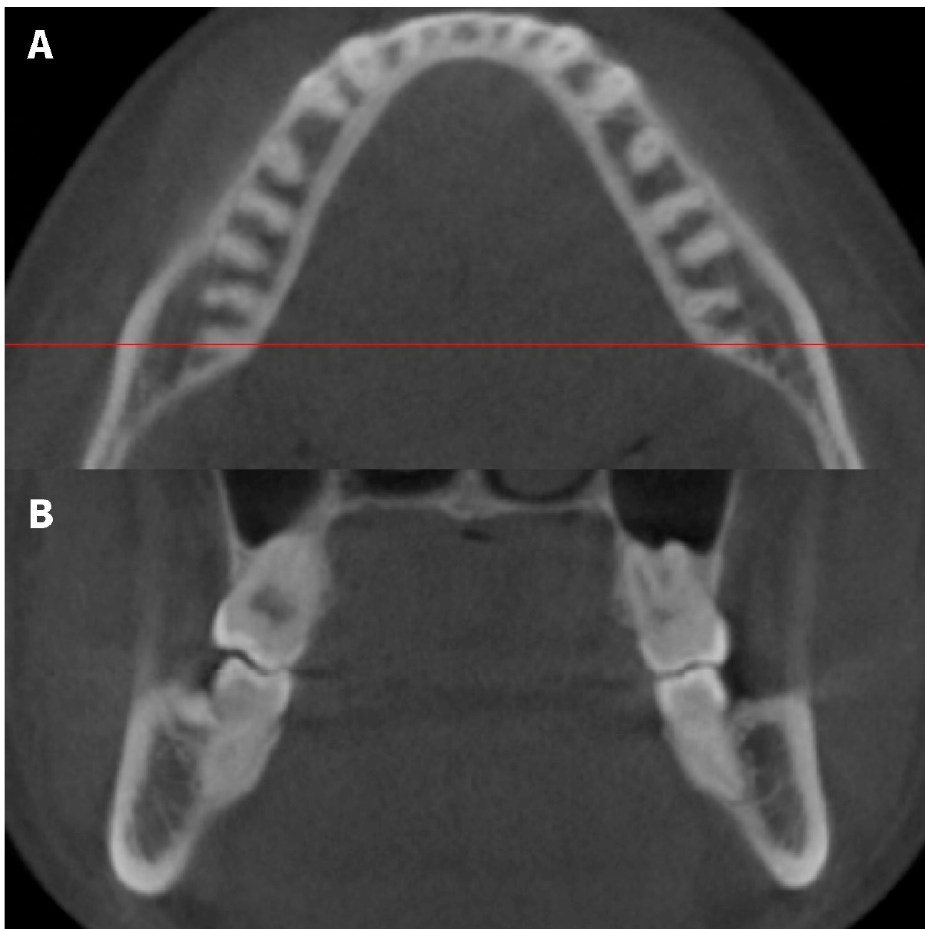
Figure 5. CBCT multiplanar reconstruction images showing contacts between distal roots of mandibular second molars and the lingual cortical bone. ( A ) axial view, ( B ) coronal view.